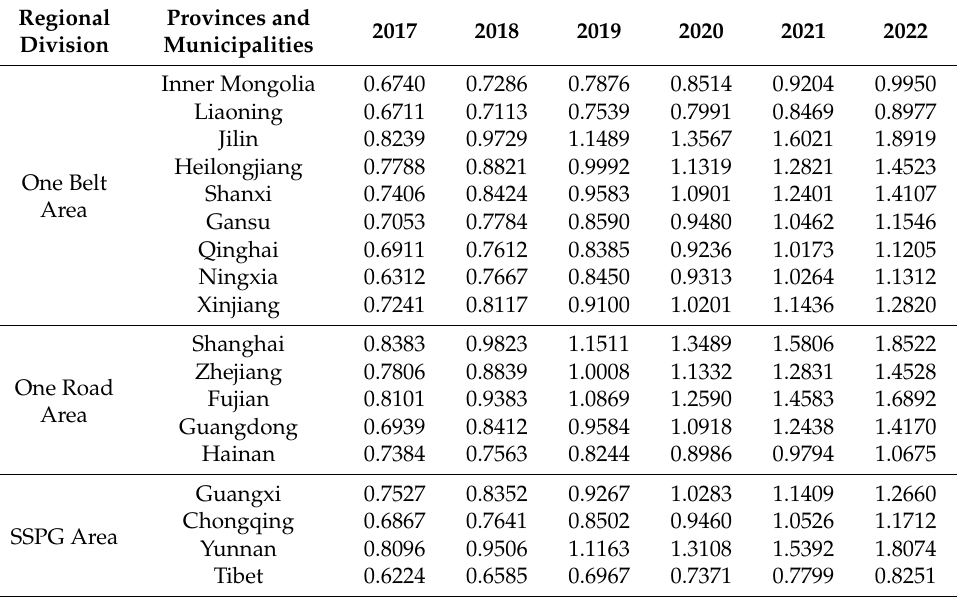
Table 6. Water security values in the B&R area of China from